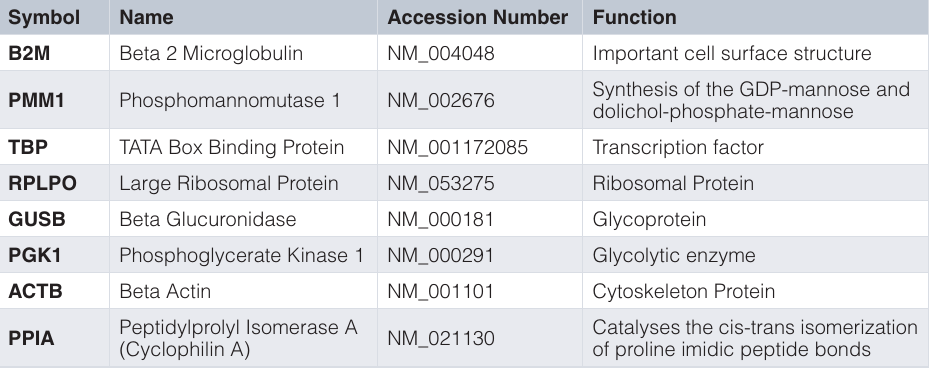
Table 1. Description of the nine candidate housekeeper genes used in the study. The accession numbers for each gene are taken from the National Center for Biotechnology Information. Symbol